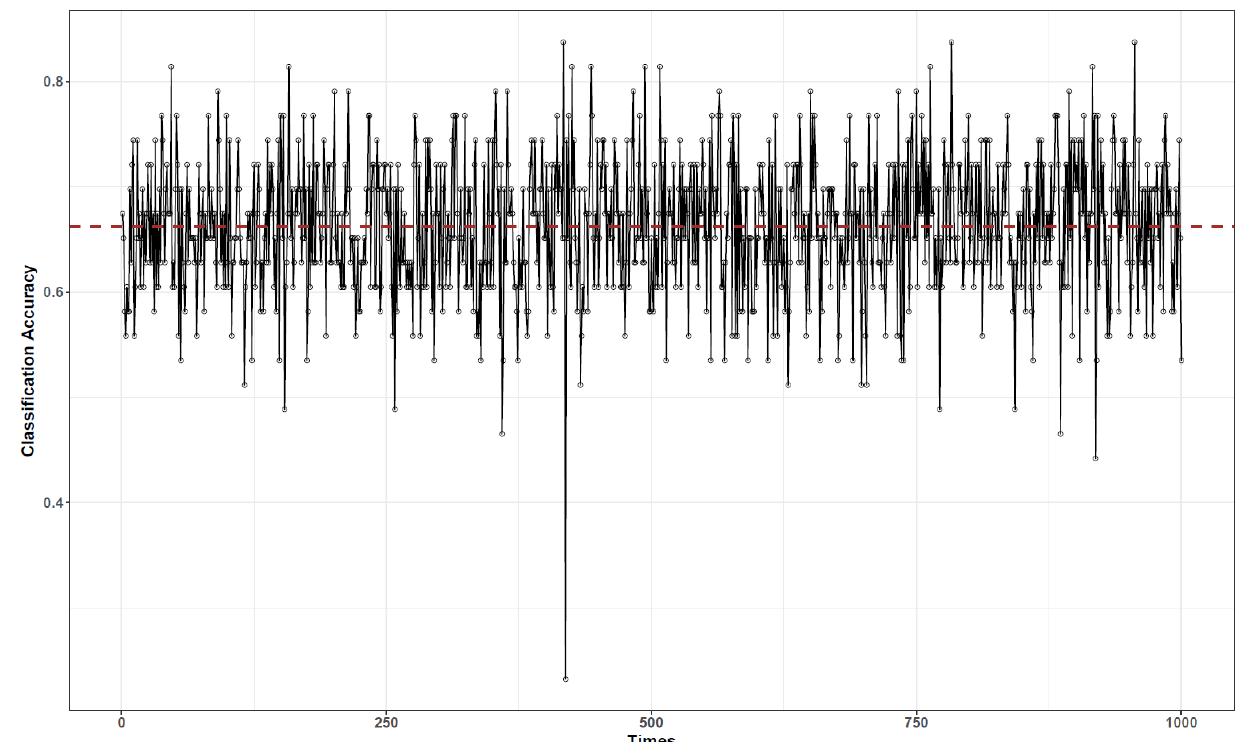
Figure 8. Validation for the Naive Bayes-based surgical phase classification.